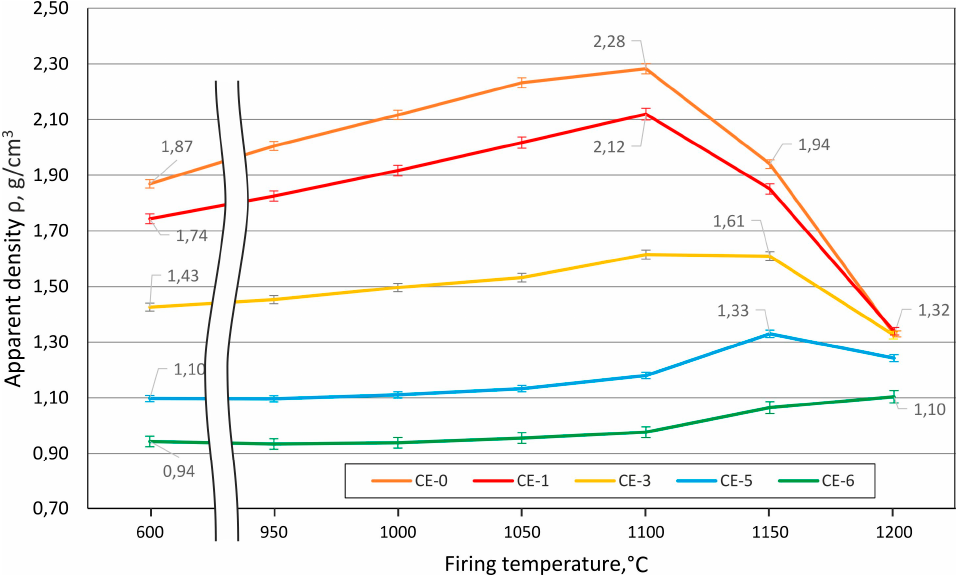
Figure 6. Apparent density dependence on the CS content and the firing temperature.